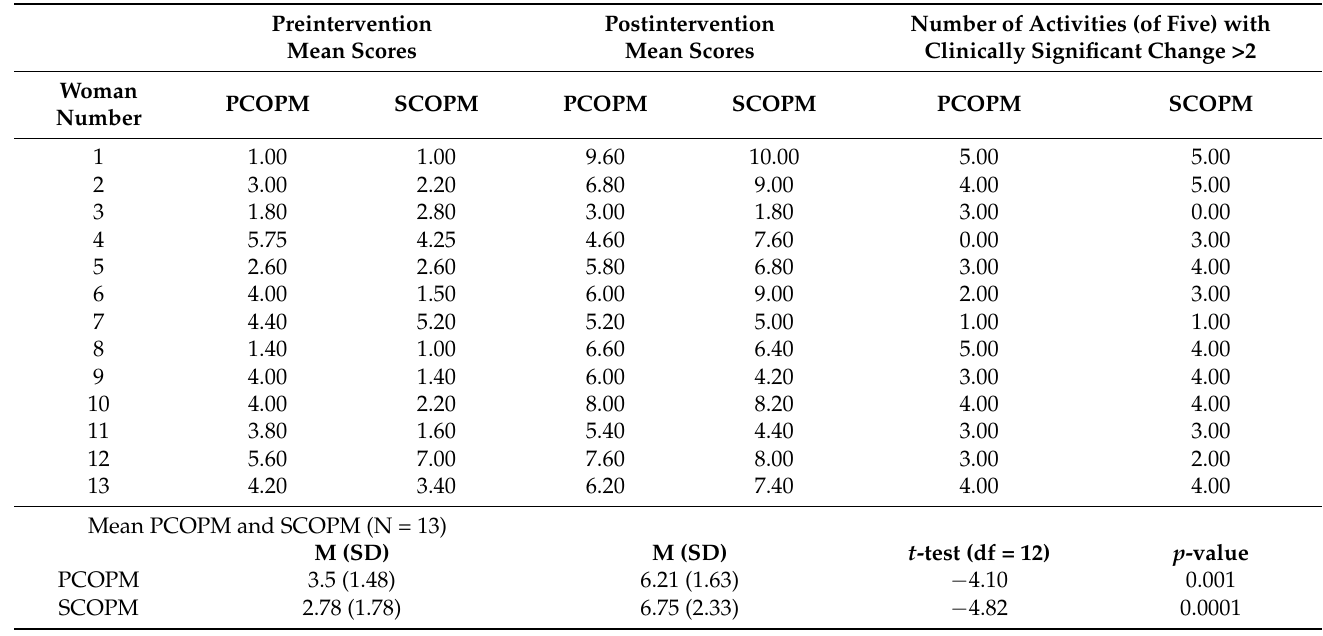
Table 2. Comparison of women’s perceived performance (PCOPM) and satisfaction with performance (SCOPM) of five meaningful activities between preintervention and postintervention assessments (N = 13).